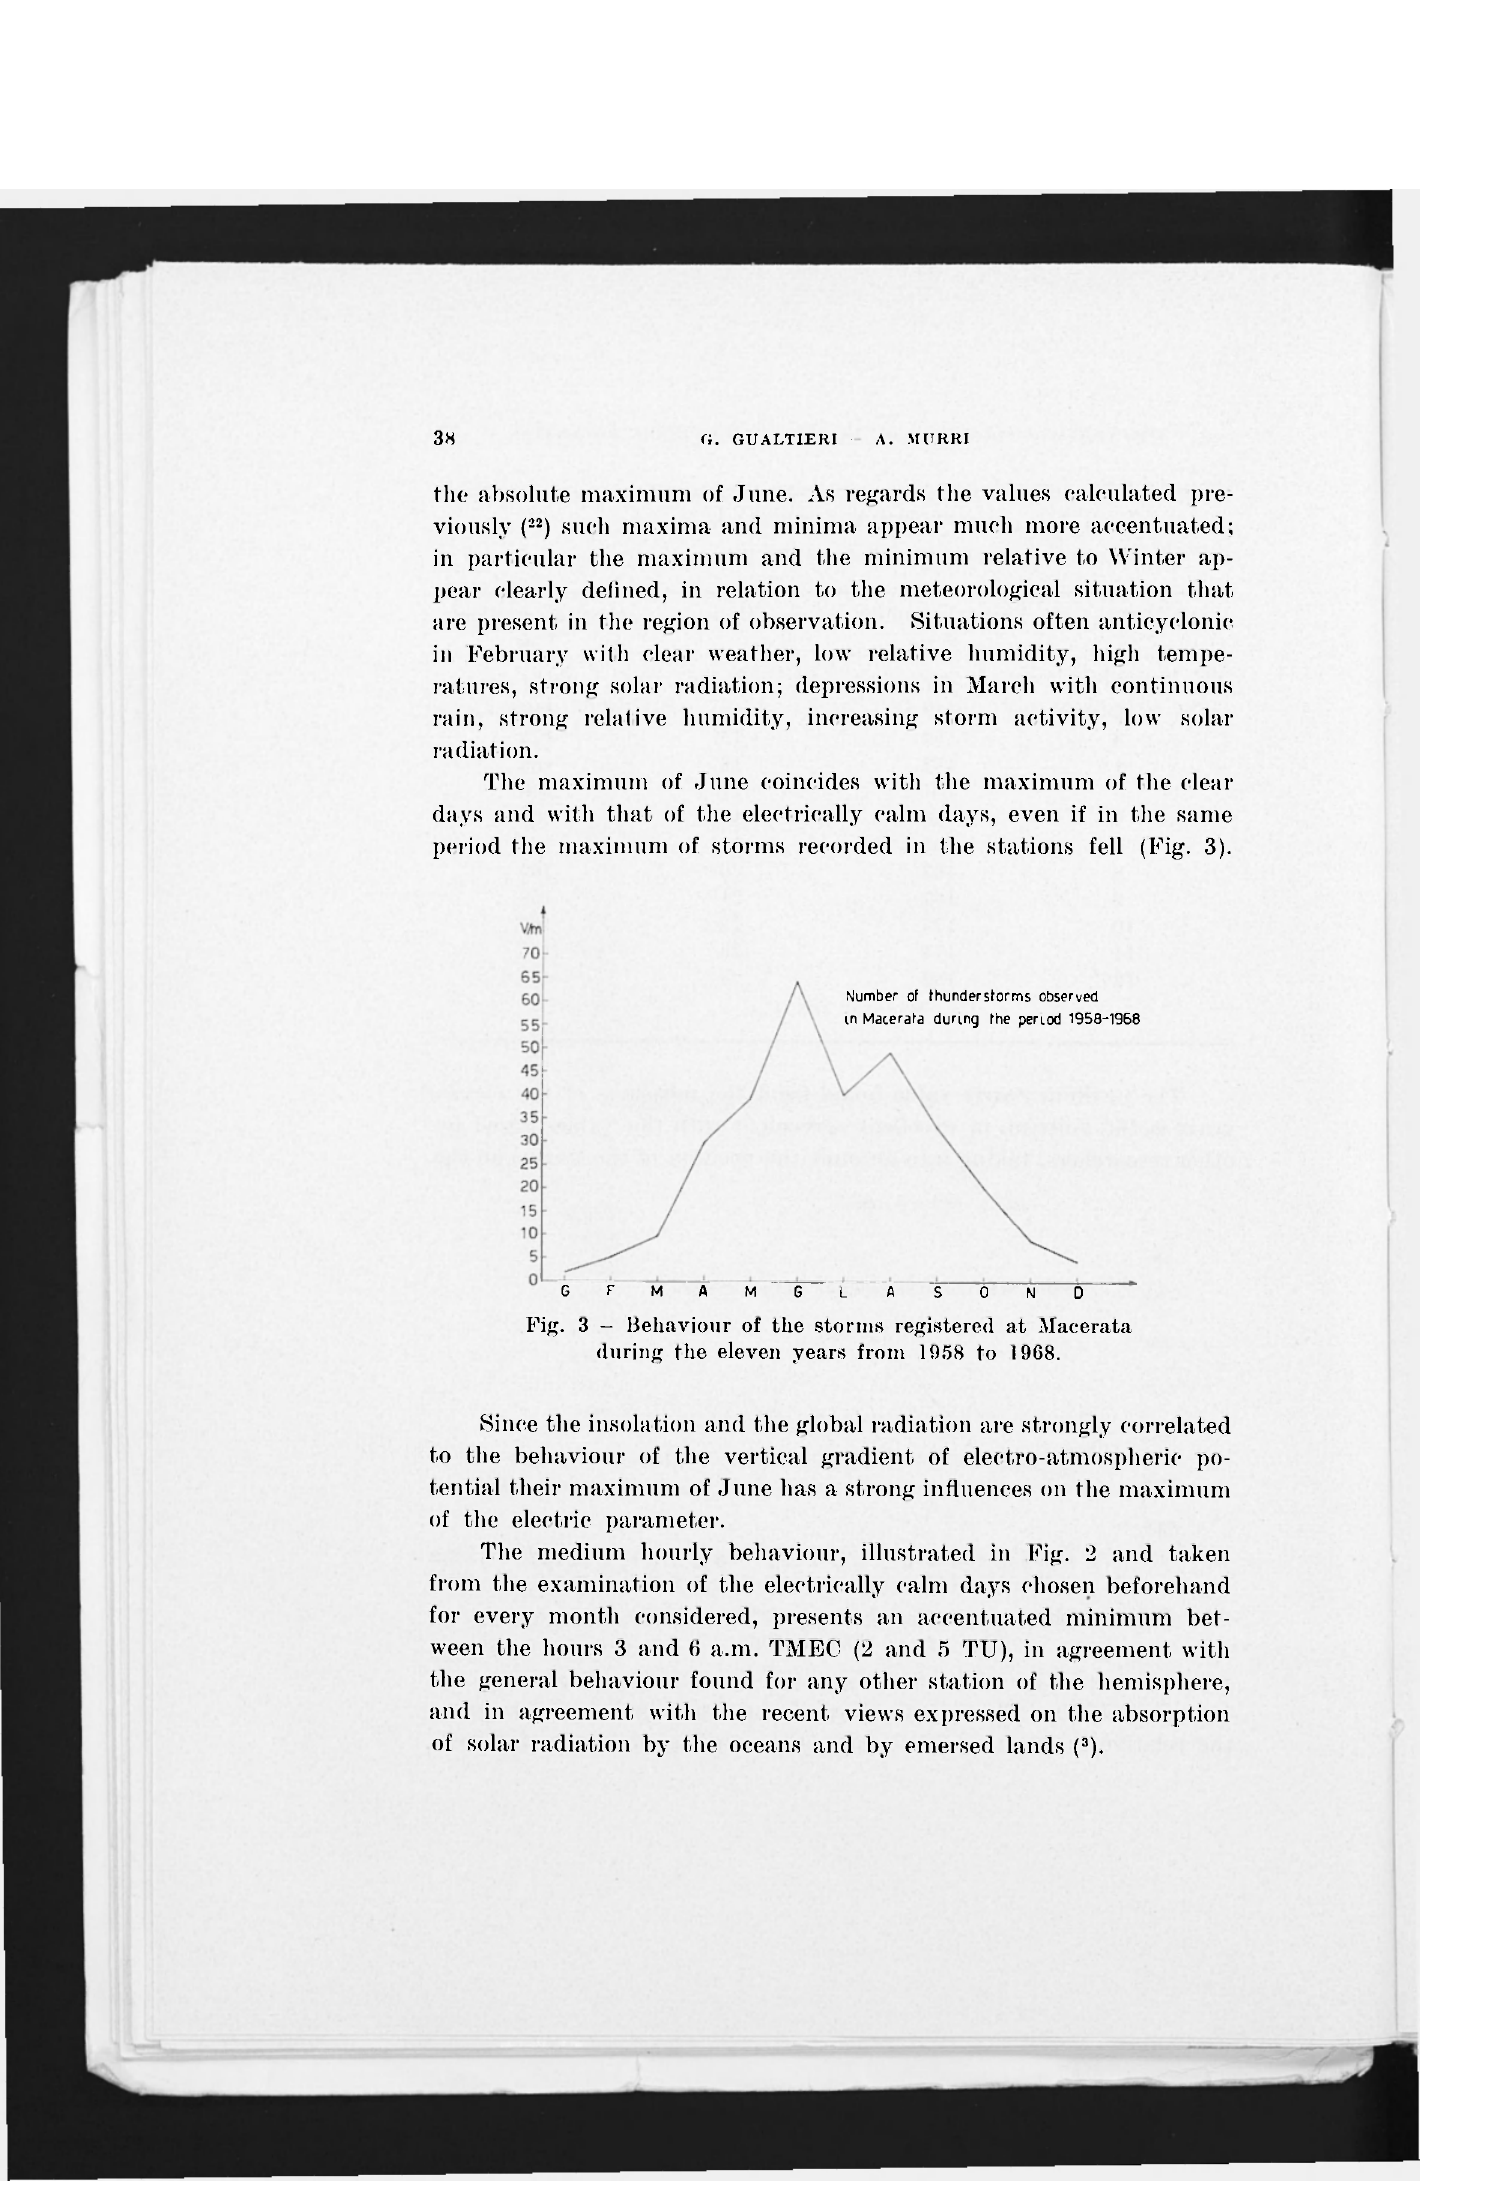
Fig. 3 Behaviour of the storms registered at Macerata during the eleven years from f958 to